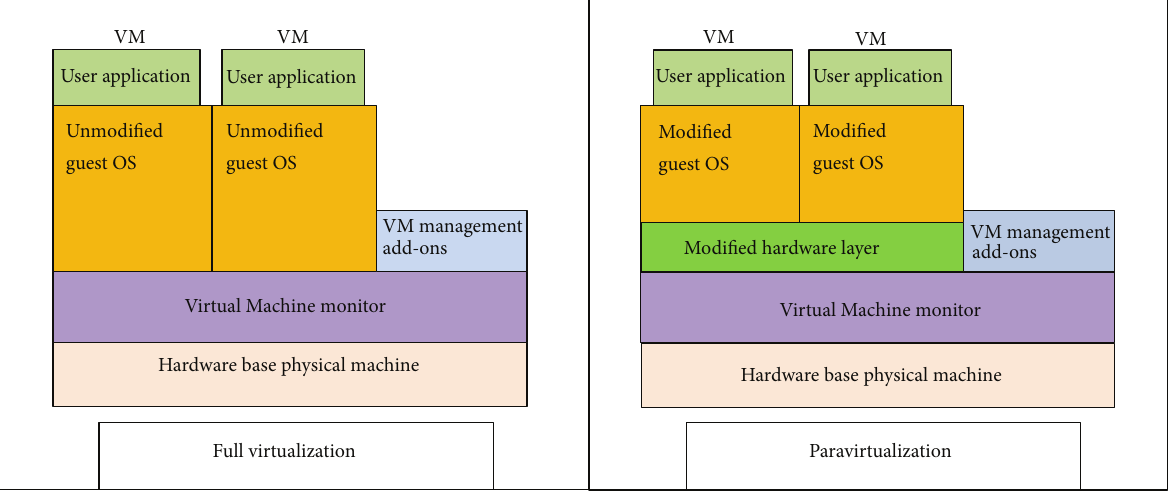
Figure 1: Virtualization platforms.